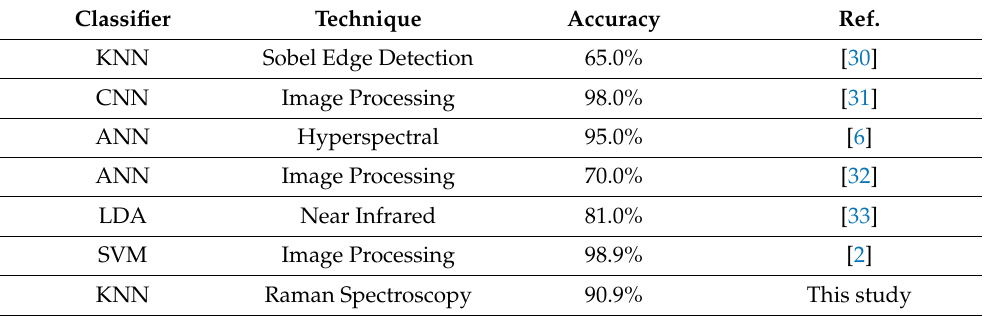
Table 4. Summary of classifiers, techniques and accuracy achieved for oil palm ripeness